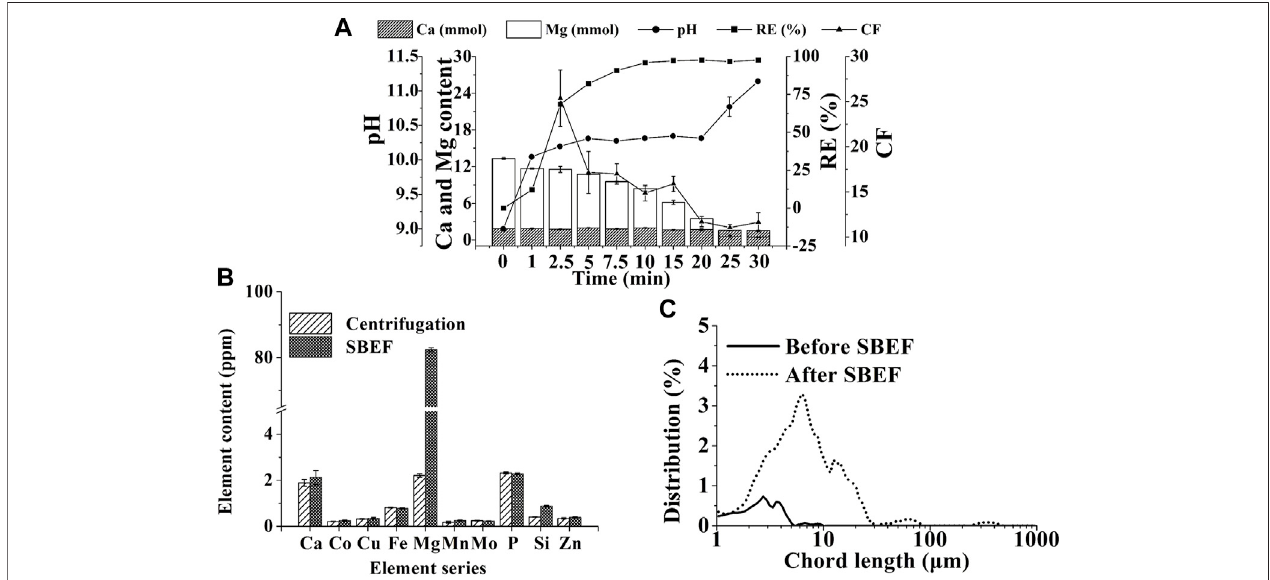
FIGURE 5 | Flocculation mechanism of SBEF: (A) performance of SBEF with varied operation time (concentration of Ca 2+ and Mg 2+ , pH of algae culture, recovery ef fi ciency, and concentration factor); (B) the content of key elements in N. oculata biomass; (C) algae particle size distribution during the SBEF process. Data were average ±standard deviation of three independent determinations.